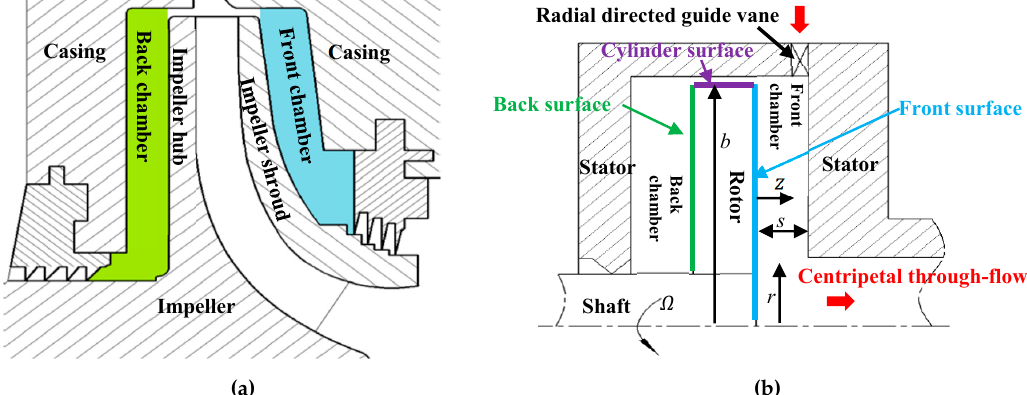
Figure 1. Meridional sketch: ( a ) a centrifugal compressor stage and ( b ) the simplified rotor-stator cavity model for a side chamber. z : axial coordinate; r : radial coordinate; s : axial gap width of the front chamber.